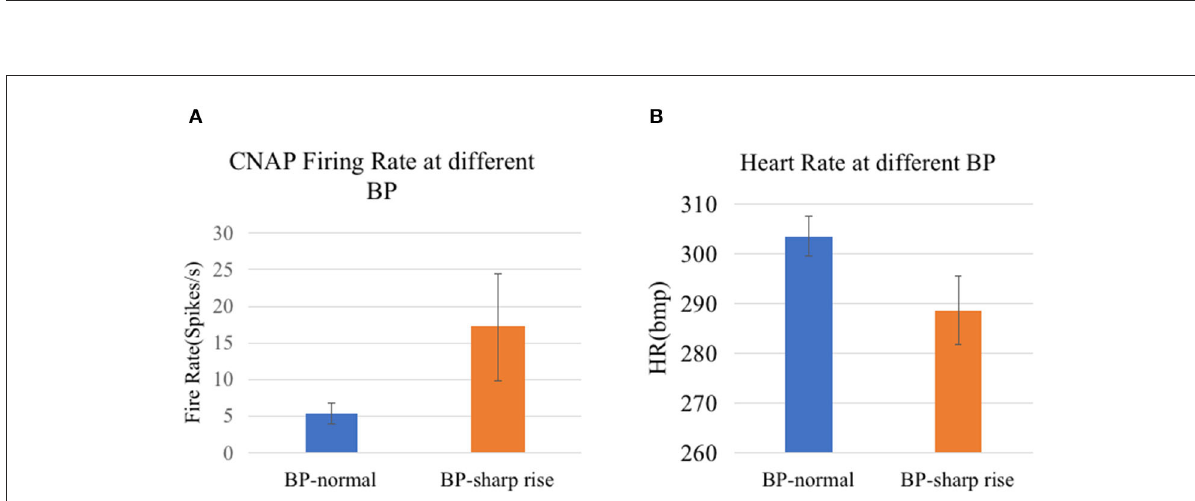
FIGURE8 (A) CNAP firing rate at different BP ( p = 0.0023). (B) Heart rate at different BP ( p =